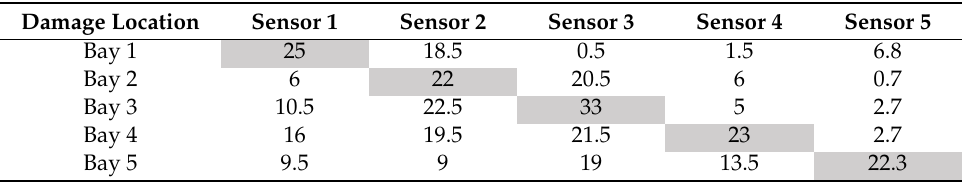
Table 2. Detectability in decibels for the JF damage analysis (DV values).